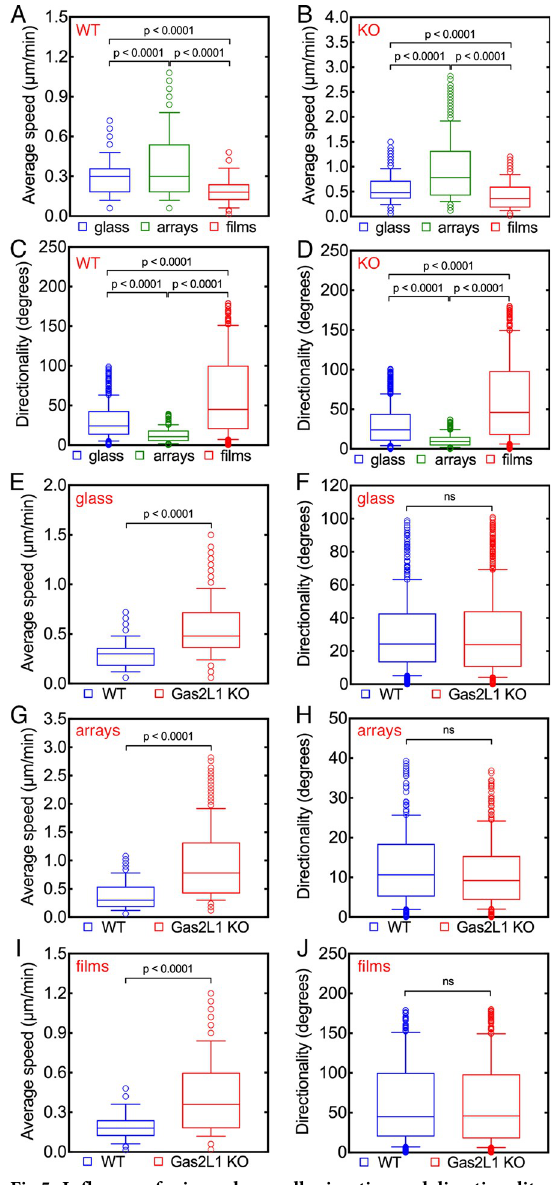
Fig 5. Influence of microgels on cell migration and directionality of wild-type and Gas2L1 KO Sertoli cells. Analysis of average speed (A, B, E, G, I) and directionality (C, D, F, H, J) of control (WT) and Gas2L1 KO Sertoli cell migration. On glass, microgel films and microgel arrays, Gas2L1 KO cells are significantly faster than control cells (A, B, E), whereas no significant difference can be observed regarding the directionality of their migration (C, D, F). Both control and Gas2l1 KO cells move faster on microgel arrays and slower on microgel films compared to glass controls (A, B). Changes in the directionality of migration are significantly greater with both cell types on glass and microgel films (H, J). Numbers indicate p values. ns: Not